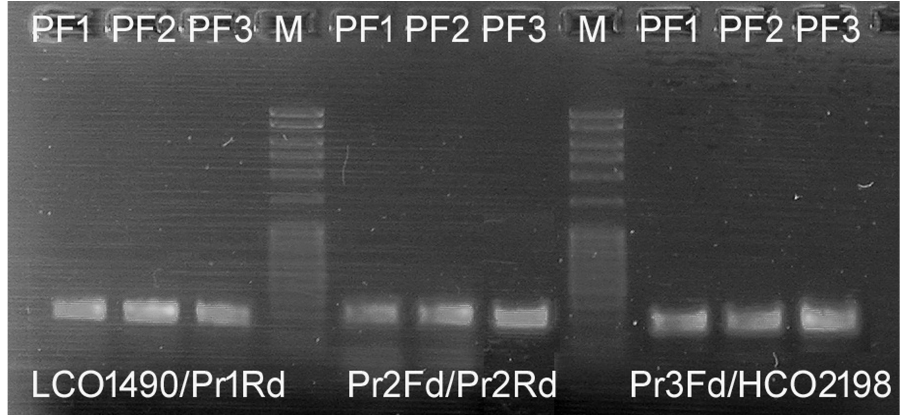
Figure 3. Agarose gel visualizing the products of direct PCR in initial trials testing the novel primers with fresh Praon samples. Three direct PCR reactions were conducted with primer pairs: 1. LCO1490/Pr1Rd, 2. Pr2Fd/Pr2Rd, 3. Pr3Fd/HCO2198. The species included in trials are PF1- P. volucre , PF2- P. dorsale , PF3- P. abjectum ; M –